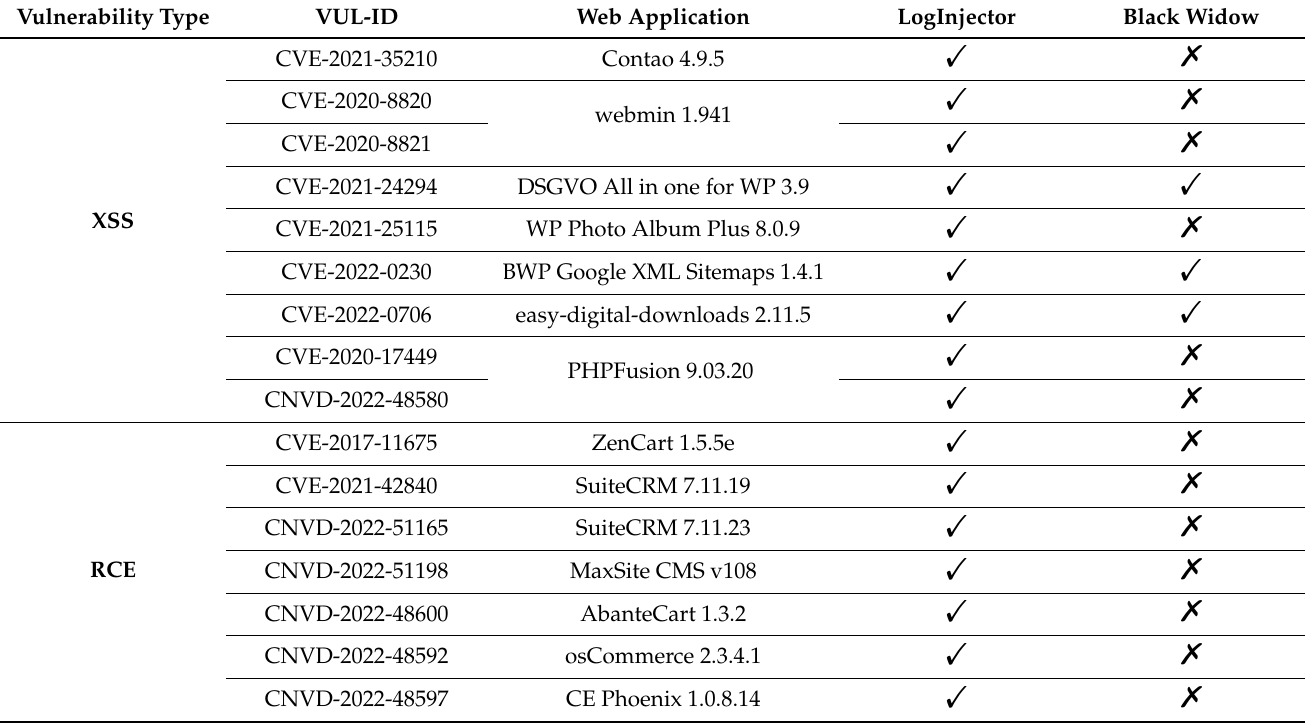
Table 7. Vulnerability Detection Capability